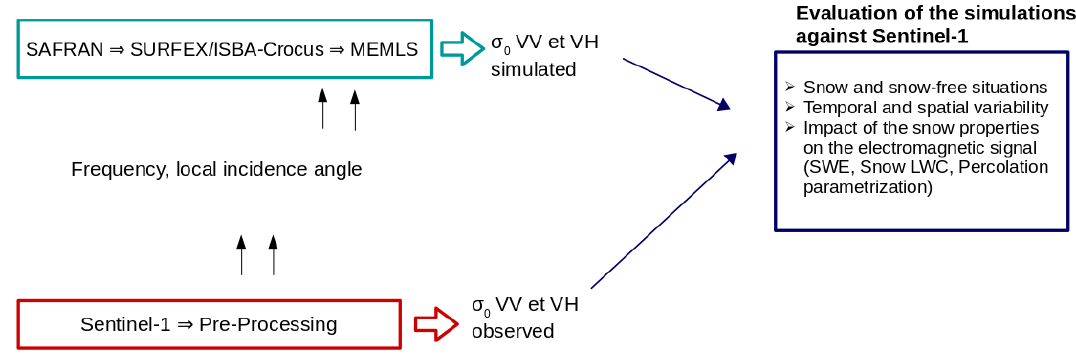
Figure 4. Flow chart of the method employed in this study for observations, simulations, and their